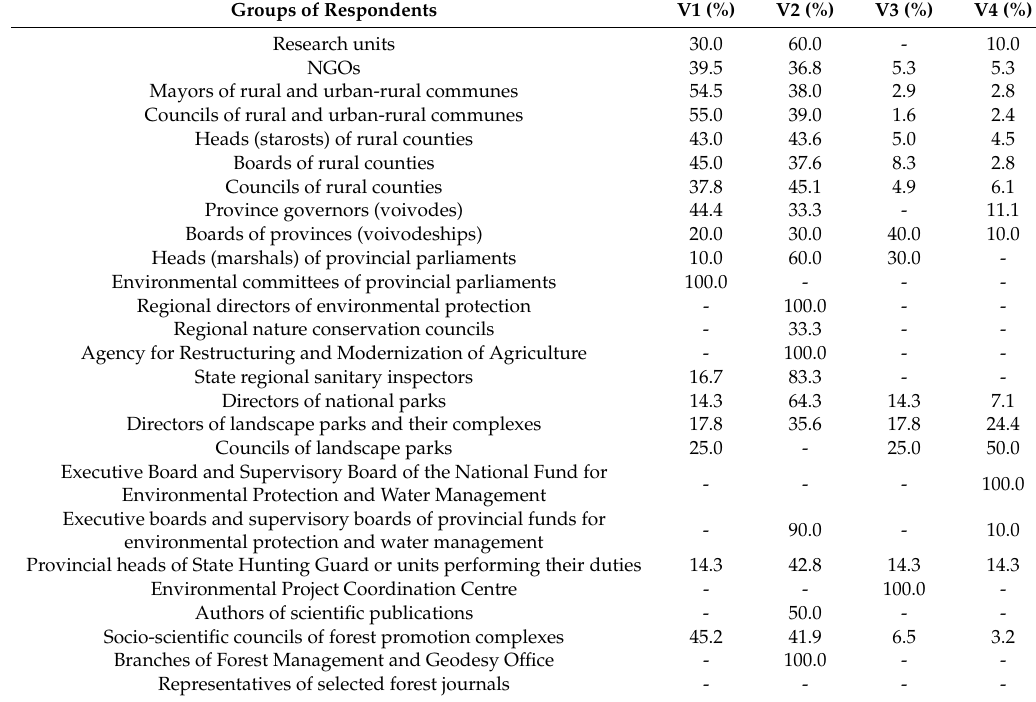
Table 2. The four most frequently chosen variants to answer Question 1 (who should determine the principles / methods of nature conservation in the area of the State